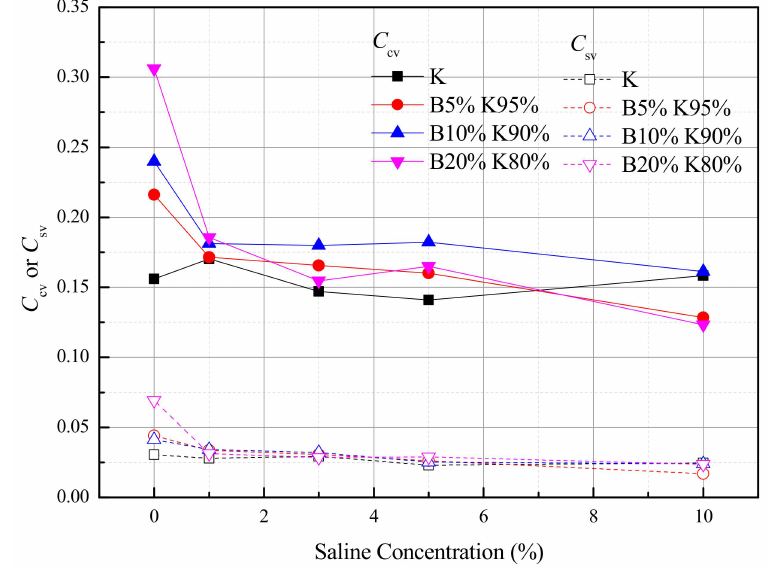
Figure 4. The volume compression index C cv and the swelling index C sv of the clays changed with sodium chloride